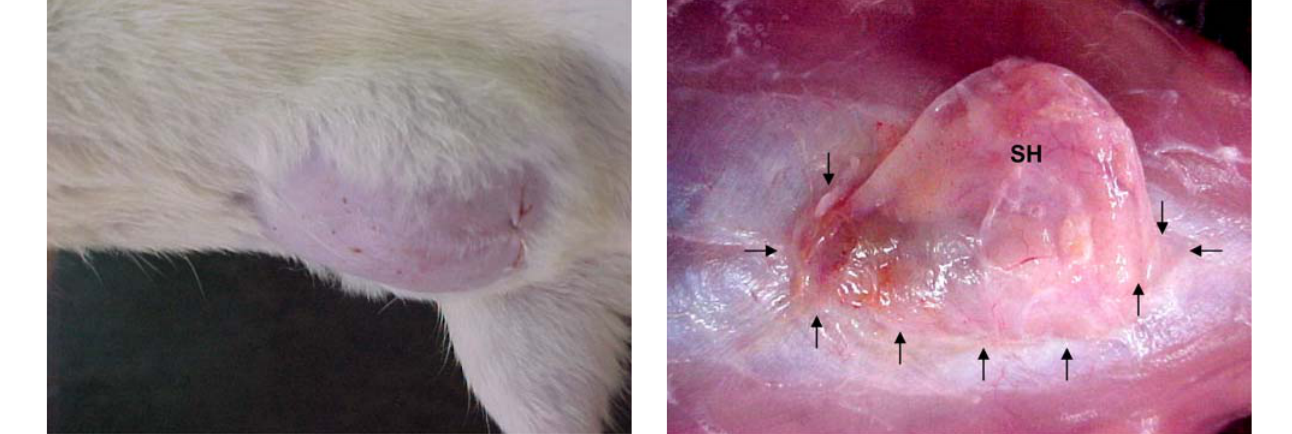
FIGURA 1A - Ectoscopia do rato do subgrupo controle de 28 dias, com hérnia incisional.